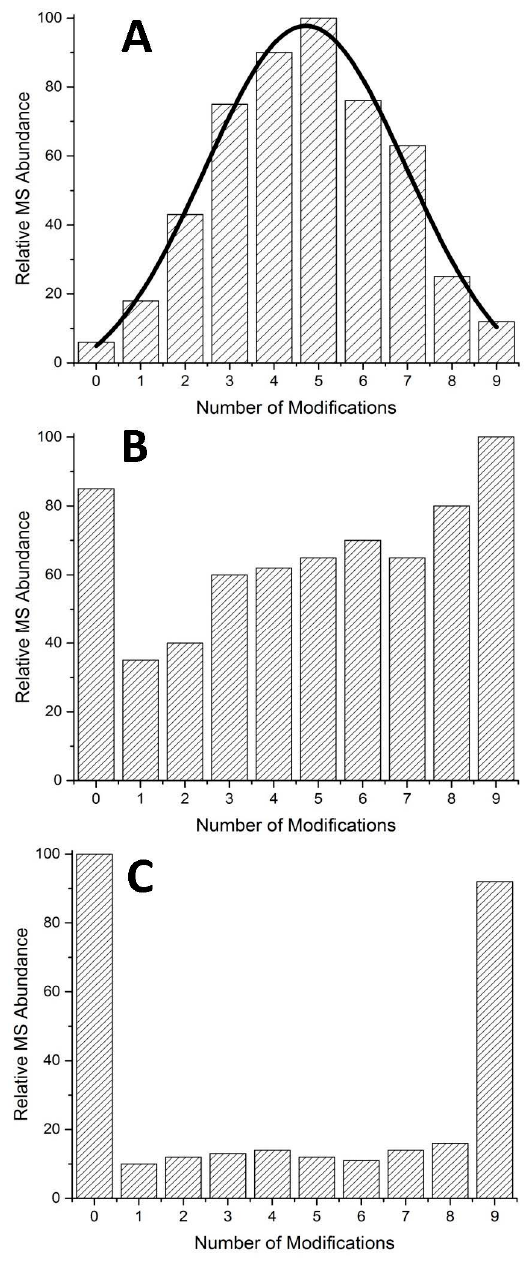
Figure 4. Examples of possible modification distributions in typical mass spectra. ( A ) Normal distribution of modified species where small amounts of apo- (0 modifications) and fully modified species (9 modifications) exist simultaneously; ( B ) semi-cooperative pattern, has significant amounts of the apo-species, intermediates (1–8 modifications), and fully modified species; ( C ) cooperative pattern, where few intermediates exist and the spectra is dominated by the apo- and fully modified species.